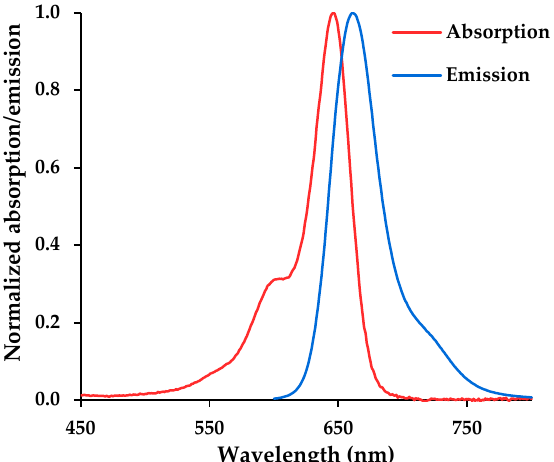
Figure 5. Normalized absorption and emission spectra of sulfo-Cy5 carboxylic acid 4 (1 × 10 − 6 M) at pH 7.4 in PBS.